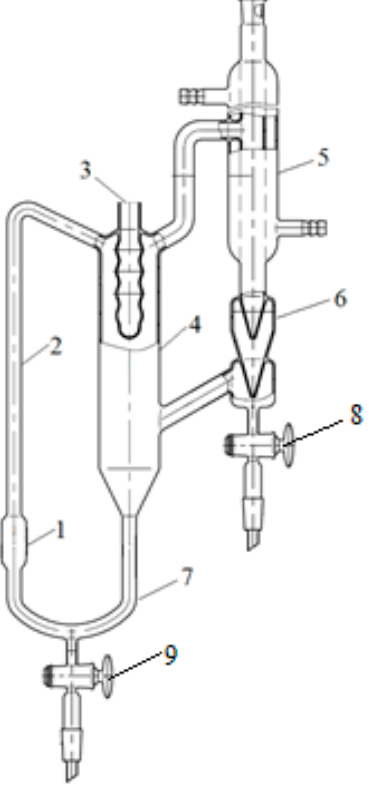
Figure 3. Swietoslavsky ebuliometer: 1—cube; 2—Cottrell pump; 3—pocket for a thermometer; 4—separation space; 5—refrigerator; 6—drop counter; 7—overflow tube; 8,9—distillate and cube sampling valve.